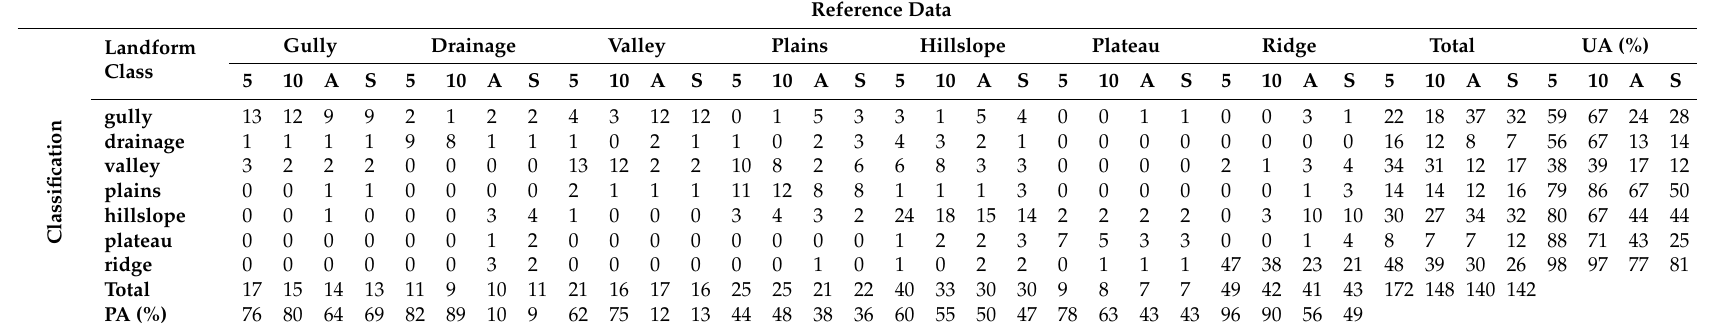
Table A2. Error matrix based on classified landform units for the TPI approach for the four different DEMs (5 = 5 m, 10 = 10 m, A = Aster 30 m, S = SRTM 30 m) with producer’s accuracy (PA) and user’s accuracy